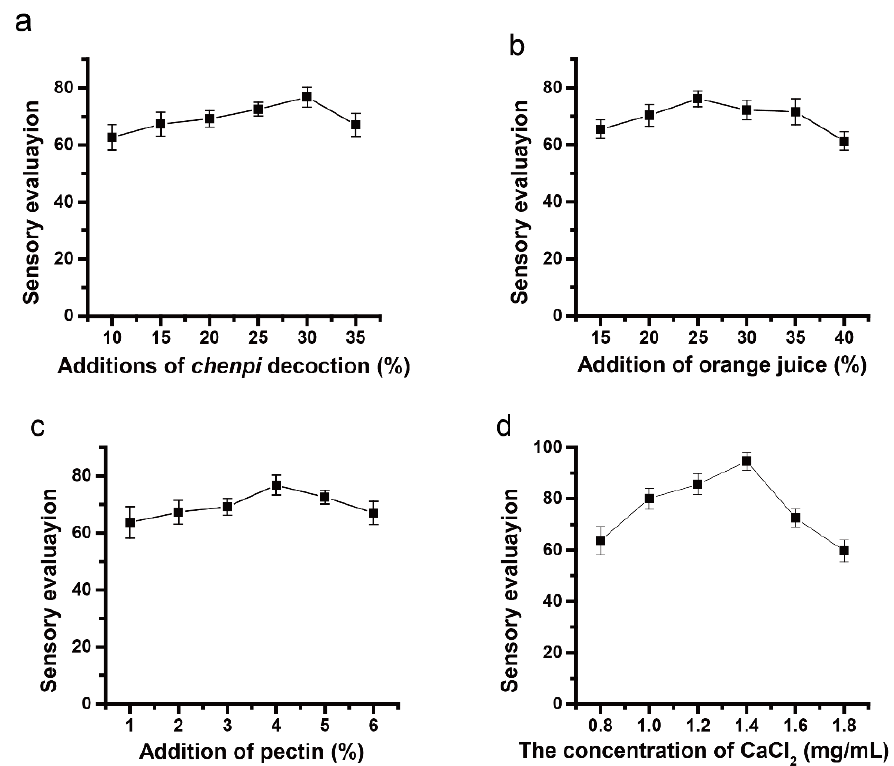
Figure 1. The effect of the single factor on the CFJ. ( a ) The effect of the additions of the chenpi decoction on the total sensory evaluation of the CFJ (the highest total sensory score for CFJ at 30% chenpi decoction); ( b ) the total sensory evaluation score of the CFJ varies with the additions of orange juice (15%-40%) (the highest total sensory score for CFJ at 25% orange juice); ( c ) effect of pectin on the total sensory evaluation of the CFJ (the highest total sensory score for CFJ at 4% pectin); ( d ) effect of the concentration of CaCL 2 on the total sensory evaluation of the CFJ (the highest total sensory score for CFJ at 1.4 mg/mL CaCL 2